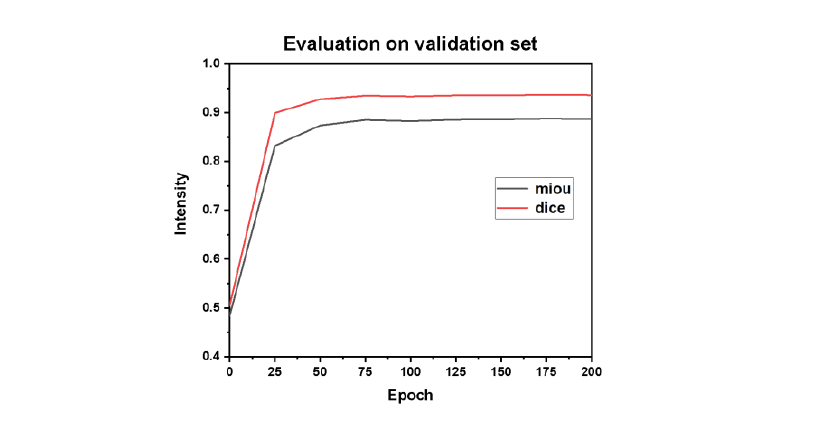
Fig. 3. Evaluation of the final training results in the validation set contained the mean intersection over union (MIOU) curve and the dice coefficient curve.